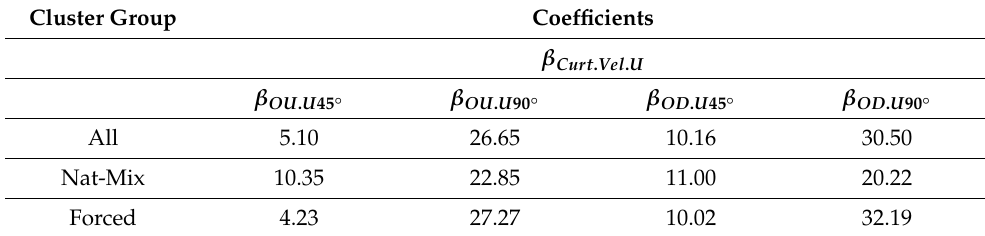
Table 5. Continuation of Table 4 listing the remaining